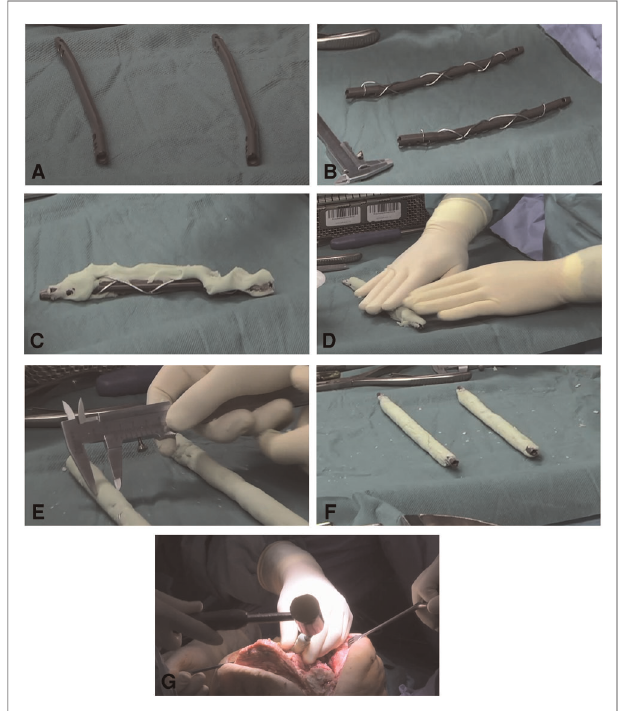
FIGURE 1 | Polymethyl methacrylate (PMMA)-coated intramedullary nails. ( A, B ) 2-Humerus nails (Stryker, Duisburg, Germany) are wrapped with a 1.25- mm steel cerclage wire for reinforcement. ( C, D ) PMMA cement (Copal ® , Heraeus Medical GmbH, Wehrheim, Germany) is applied to